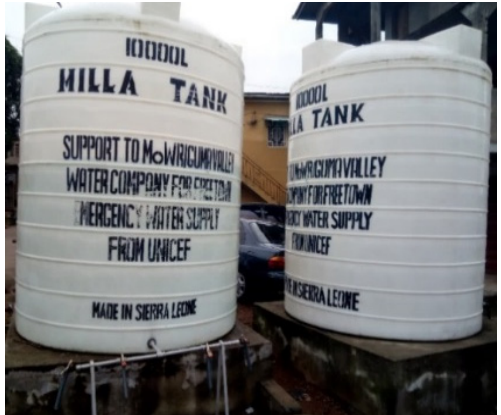
Figure 3. A 10,000 L tank located next to a public standpipe point at Congo Town.